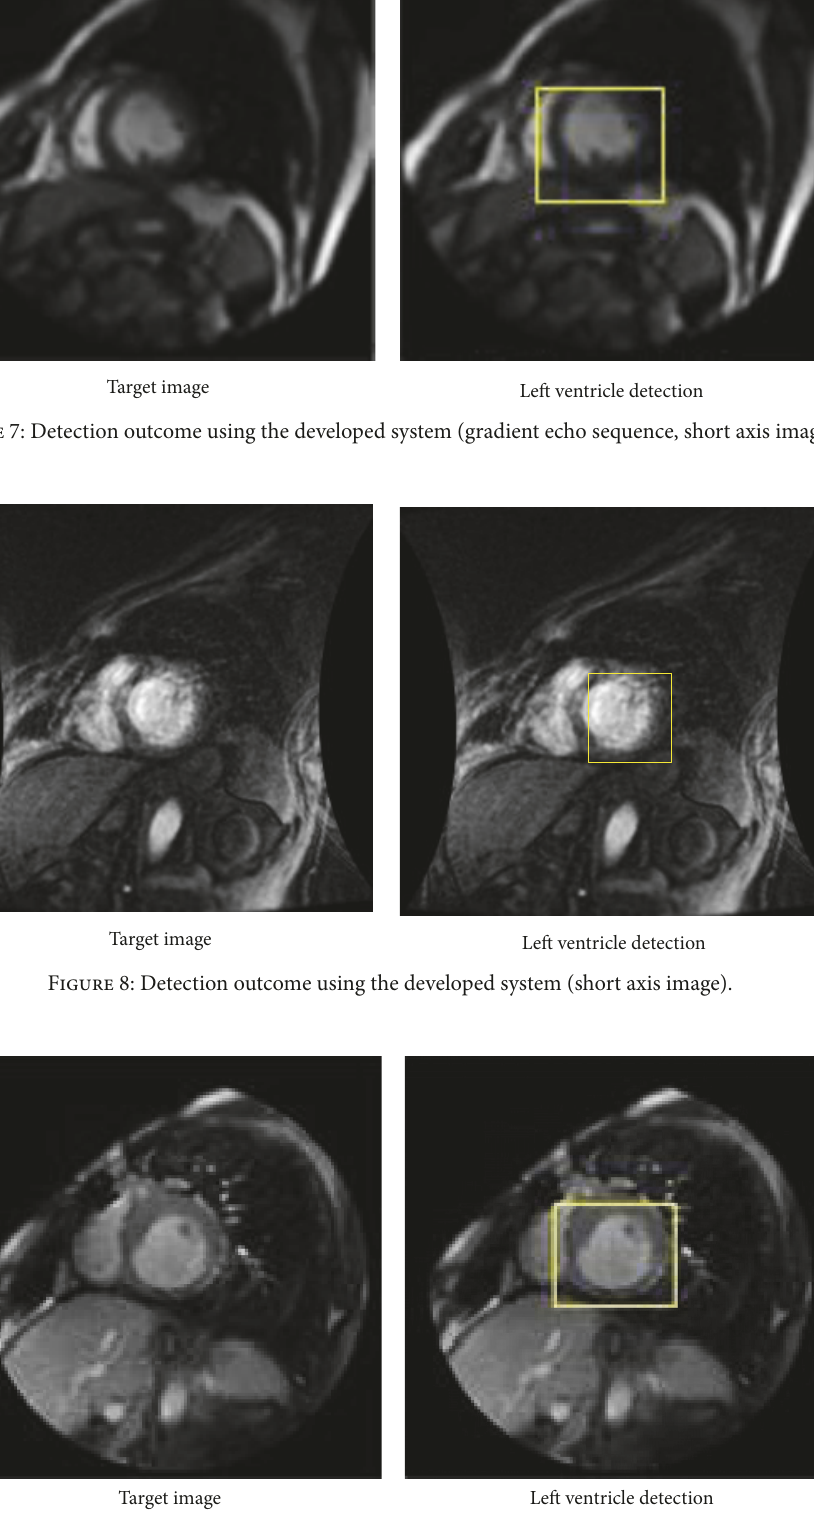
Figure 9: Detection outcome using the developed system (short axis